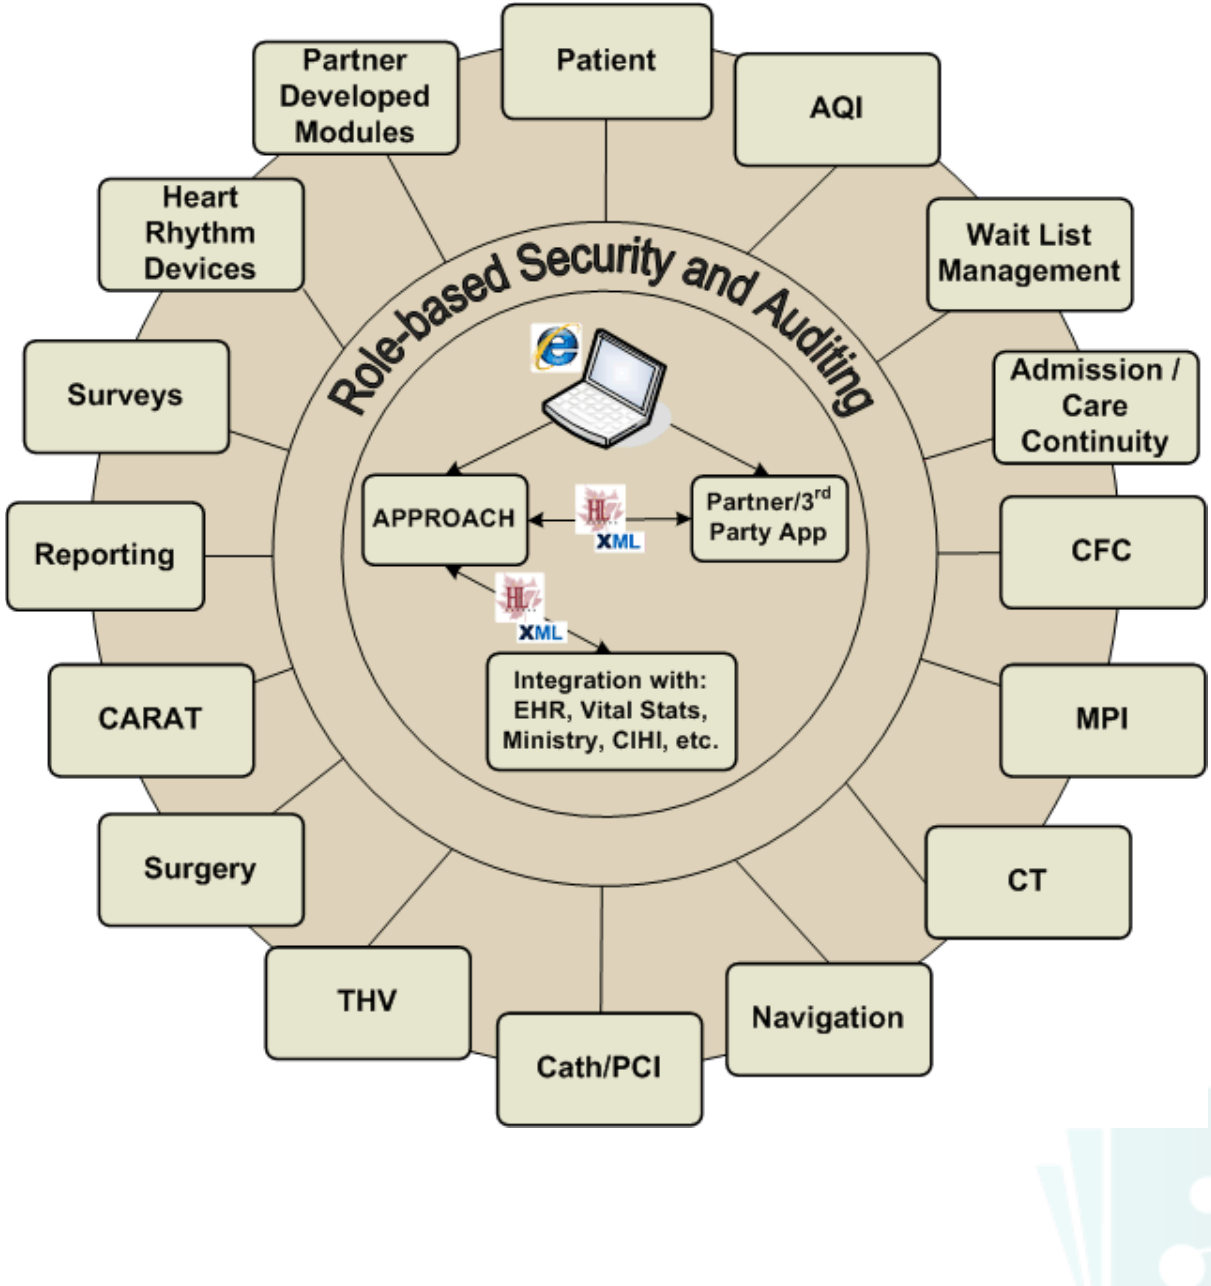
Figure 1: Data modules in the Alberta Provincial Project for Outcome Assessment in Coronary Heart Disease (APPROACH)